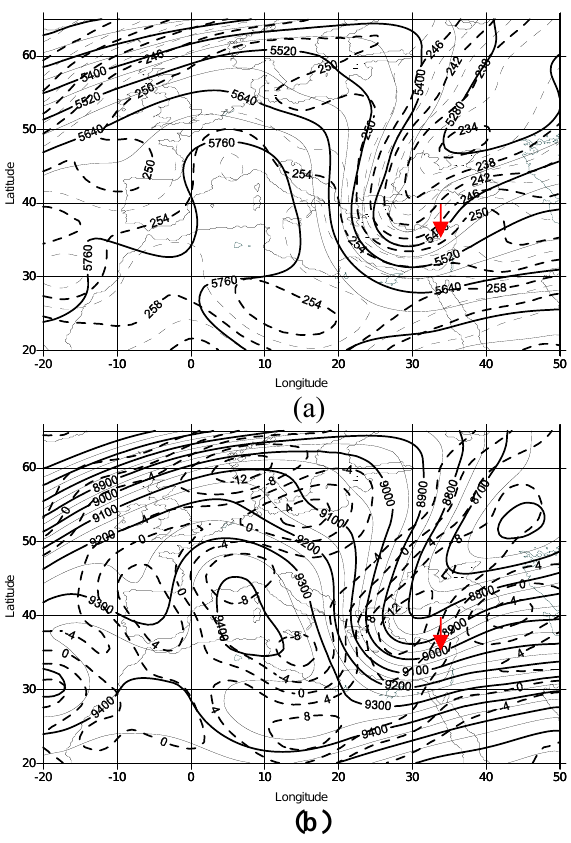
Fig. 9. As Fig. 4, but for 00:00UTC 29 January 2008.